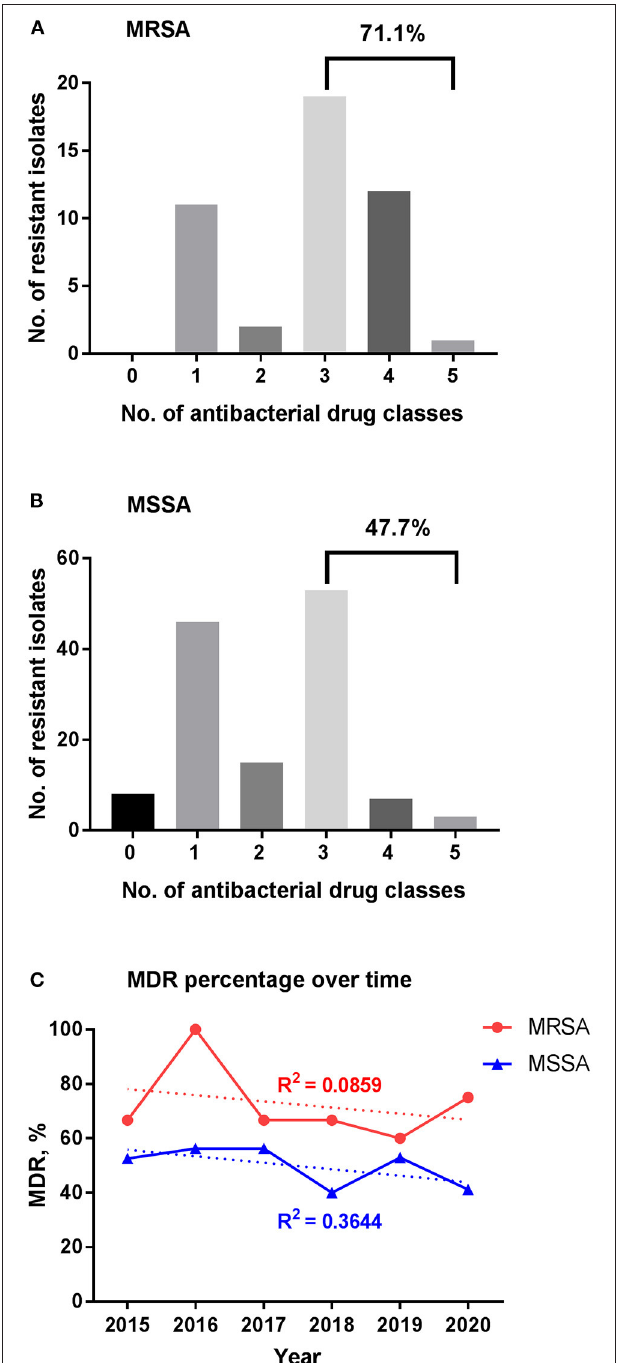
than 15% in the patients under 20 years of age (2009–2013) (29), and lower than 40% from the study of Malena (2002–2009)